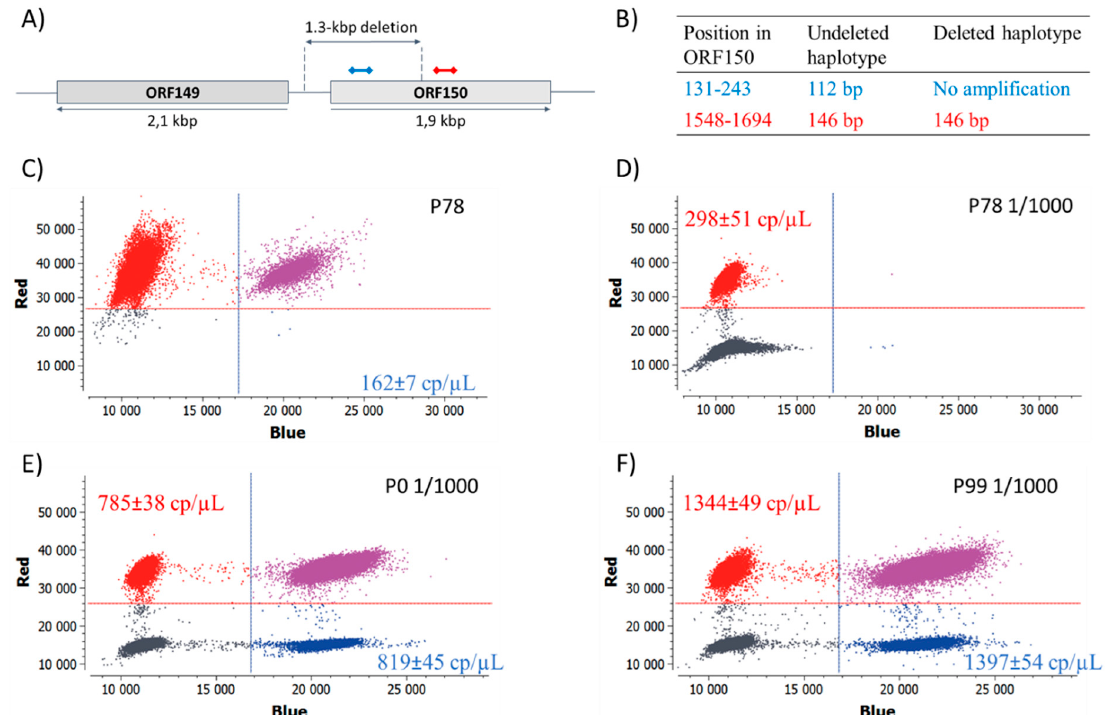
Figure 4. Quantification of deleted and undeleted haplotypes by digital PCR. ( A ) Schematic representation of the assay design and, ( B ) expected amplification products. ( C – F ) Fluorescence intensities of all the partitions in the red and blue channels, and estimated concentrations of the corresponding amplicons (mean ± SD of 3 replicates, in copy / µ L). The red channel reflects the concentration of both haplotypes, and the blue channel reflects the concentration of the undeleted haplotype only. Purple dots represent the partitions that are positive in both channels, and the grey dots correspond to negative partitions. Y and X axes represent the fluorescence intensity in the red, and blue channels, respectively.